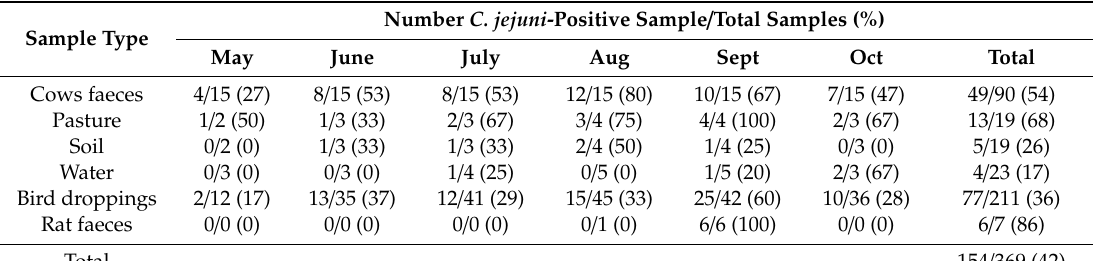
Table 1. Occurrence of C. jejuni in cows, wildlife and farm environment during the study period. Sample Type